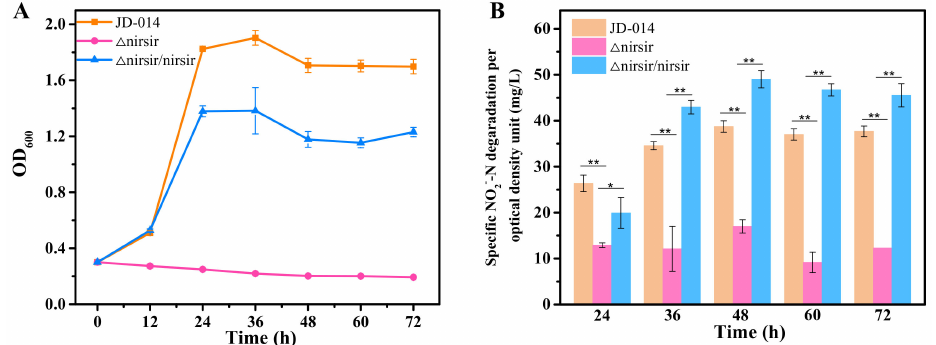
Figure 5. Comparison of nitrogen removal process among wild strain JD-014, nirsir knock-out mutant strain ( ∆ nirsir), and the corresponding complementation strain ( ∆ nirsir/nirsir). ( A ) The growth curves. ( B ) Nitrite removal characteristics. Statistical analysis was performed by using one-way analysis of variance (ANOVA) with Duncan’s test (* p < 0.05, ** p < 0.01).